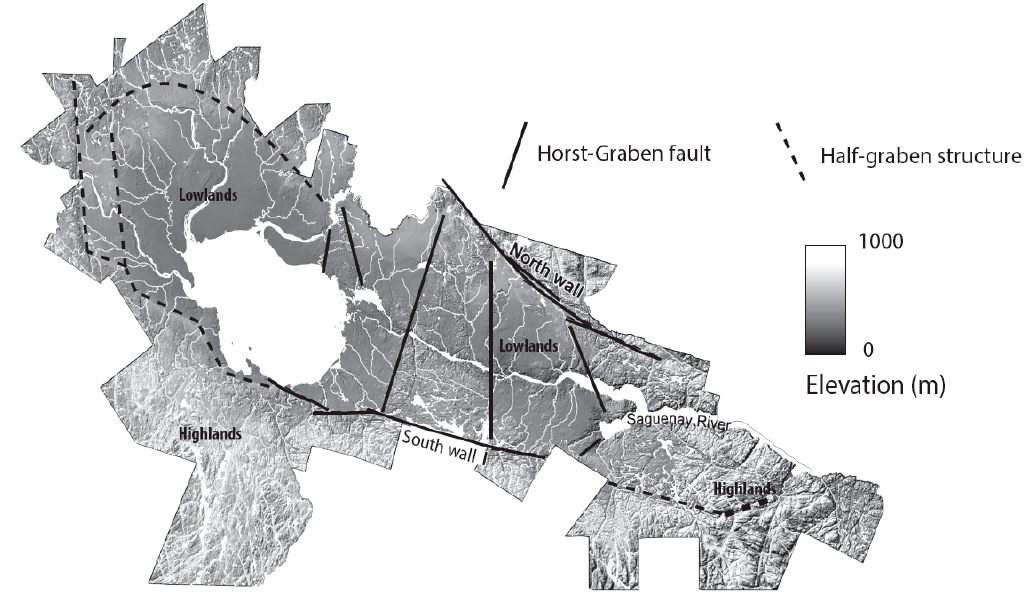
Figure 2. Digital elevation model of the study area (administrative limits) showing the highlands and the lowlands delimited by the Saguenay Horst-Graben faults. The northwestern part of the study area is characterized by a half-graben structure.